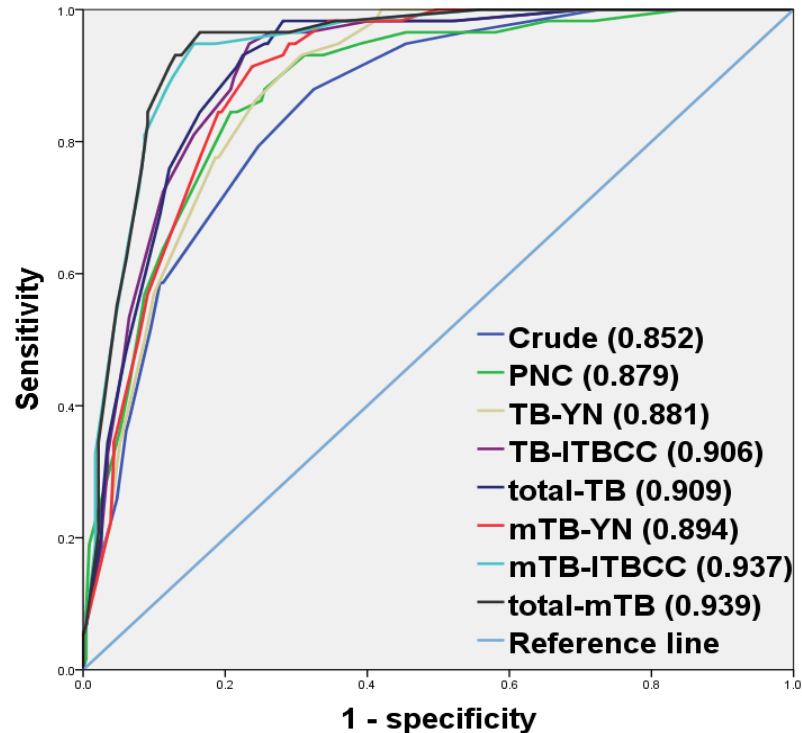
Figure 3. Comparison of receiver operating characteristic curves by multivariate logistic regression tests.